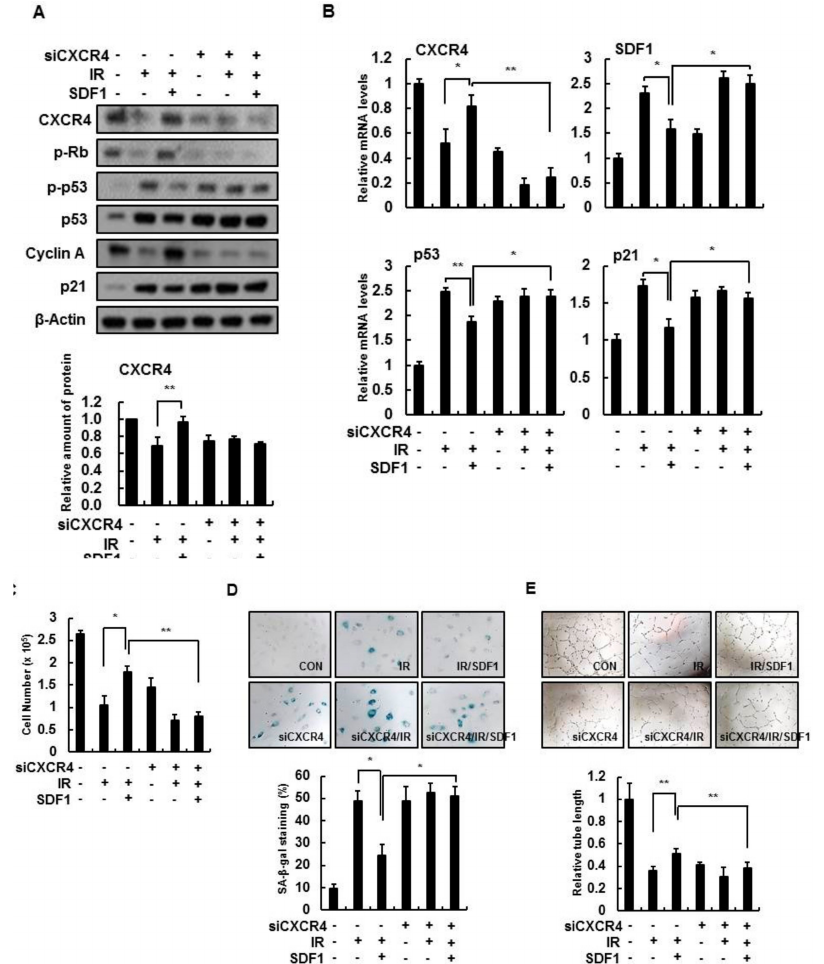
Figure 4. CXCR4 is important for SDF-1 function. ( A ) HBMVECs were transfected with CXCR4 siRNA (50 nM / mL). Western blot analysis was conducted in radiation (4 Gy)- and SDF-1 (50 ng / mL)-treated cells with CXCR4 deletions. ( B ) Expression levels of CXCR4, SDF-1, p53, and p21 were measured using real-time polymerase chain reaction analysis. ( C ) Cell number analysis was performed to measure cell proliferation. ( D ) SA- β -gal staining ( × 100) was performed in siCXCR4-transfected cells. SA- β -gal positive cells were measured and expressed as a percentage. ( E ) Tube formation experiments were performed by SDF-1 treatment in CXCR4-depleted cells. Values are expressed as the mean ± standard deviation of three independent experiments. * p < 0.05 and ** p < 0.01. siRNA, scrambled siRNA-transfected group; siCXCR4, CXCR4 siRNA-transfected group; IR, ionizing radiation; IR / SDF1, SDF-1, and radiation treated